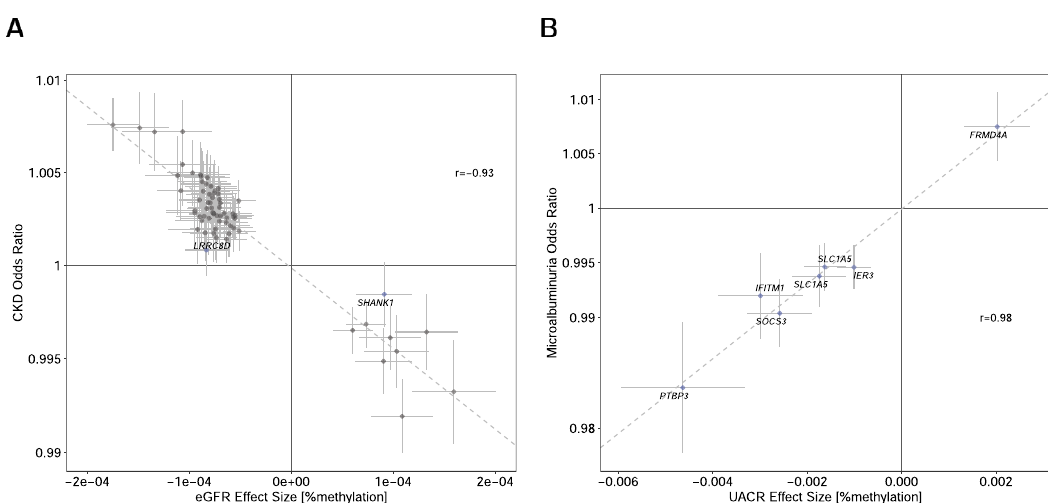
Fig. 3 Effects of eGFR-associated sites on CKD and of UACR-associated sites on Microalbuminuria. Comparison of effect estimates of the association Wald-test of the signi fi cantly associated CpG sites for estimated glomerular fi ltration rate (eGFR) ( n = 33,605) ( A ) and urinary albumin-to-creatinine ratio (UACR) ( n = 15,068) ( B ). The effects in the combined epigenome-wide association study ( x -axis) are compared with the corresponding effect sizes (odds ratio) for chronic kidney disease (CKD) ( n = 25,609) and microalbuminuria ( n = 7279), respectively ( y -axis). In panel ( A ), sites that were not nominally signi fi cantly associated with CKD (association test P -value ≥ 0.05) are colored in blue and labeled with the closest gene name. In all panels, the dashed line represents the linear regression slope between the dots, error bars indicate 95% CIs, and the Pearson correlation coef fi cient r between the effect estimates is